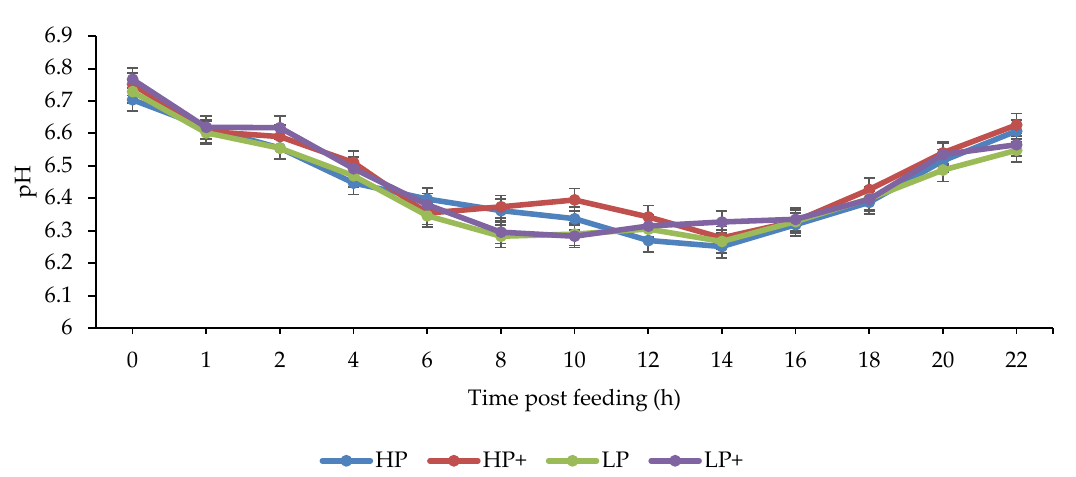
Animals 2021 , 11 , 771 Figure 1. Effect of chitosan inclusion and level of crude protein on ruminal pH. Crude protein × chitosan p > 0.05; crude protein p > 0.05; chitosan p < 0.01; time after feeding p < 0.001. 00.511.522.533.544.5